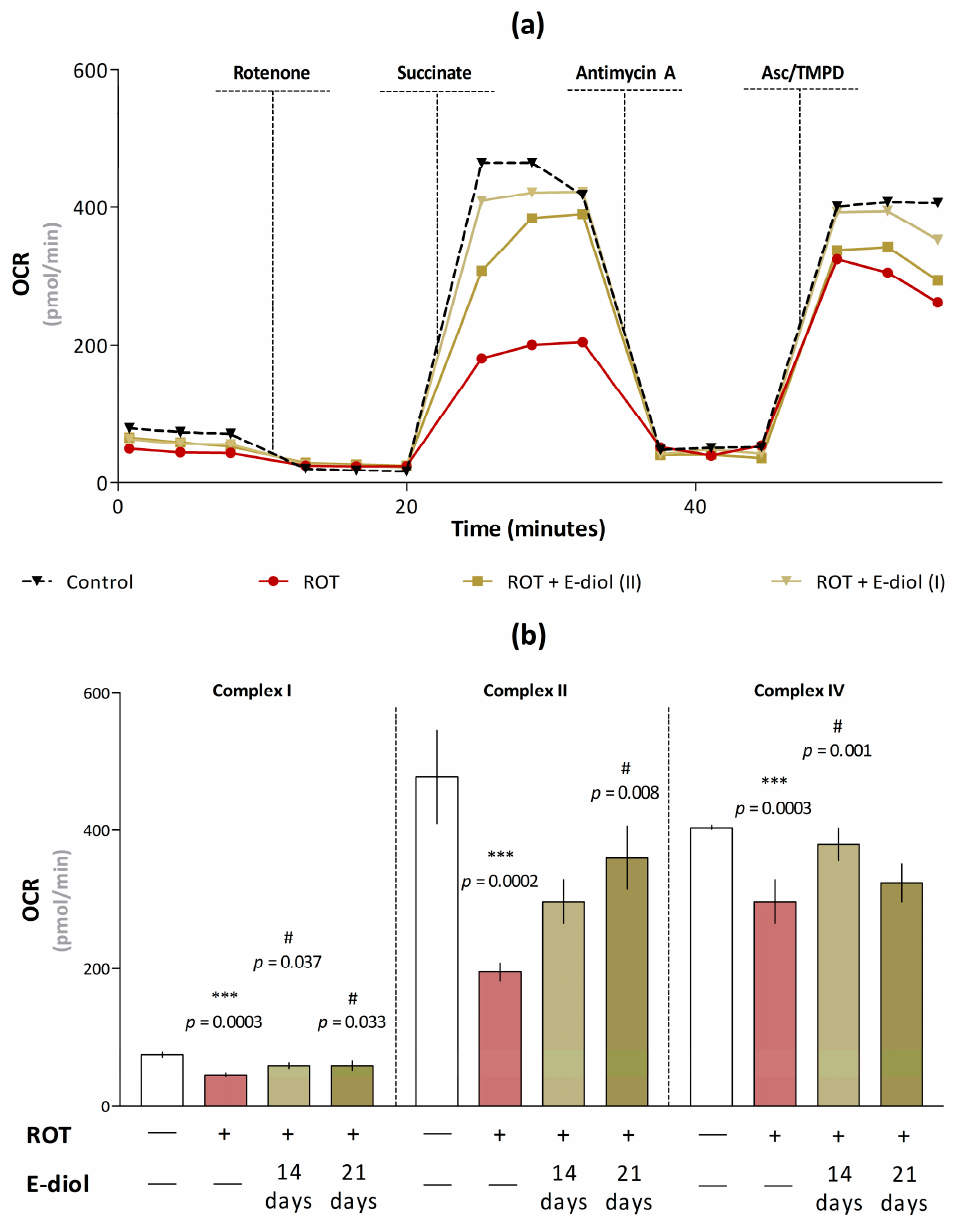
Figure 10. Analysis of oxygen consumption rate by mitochondrial p2 fraction using Seahorse XF96 Extracellular Flux Analyzer. Kinetic curves of changes in the oxygen consumption rate by organelles (10 micrograms per well) pretreated with glutamate and malate (10 mM) substrates of the respiratory chain I complex over time under the action of modulators ( a ). The concentration of rotenone was 2 µM, succinate—2 µM, antimycin A—1 µM and ascorbate/TMPD—0.5 µM. Data are shown as mean ± SEM. The data presented as histograms, in which each column represents the average value of the OCR by the organelles of the experimental groups (mean ± SEM, n = 8) ( b ). To assess the statistical significance, one-way ANOVA and Dunnett’s multiple comparison tests were used, where *** p ≤ 0.001 versus Control; # p ≤ 0.05 versus ROT.